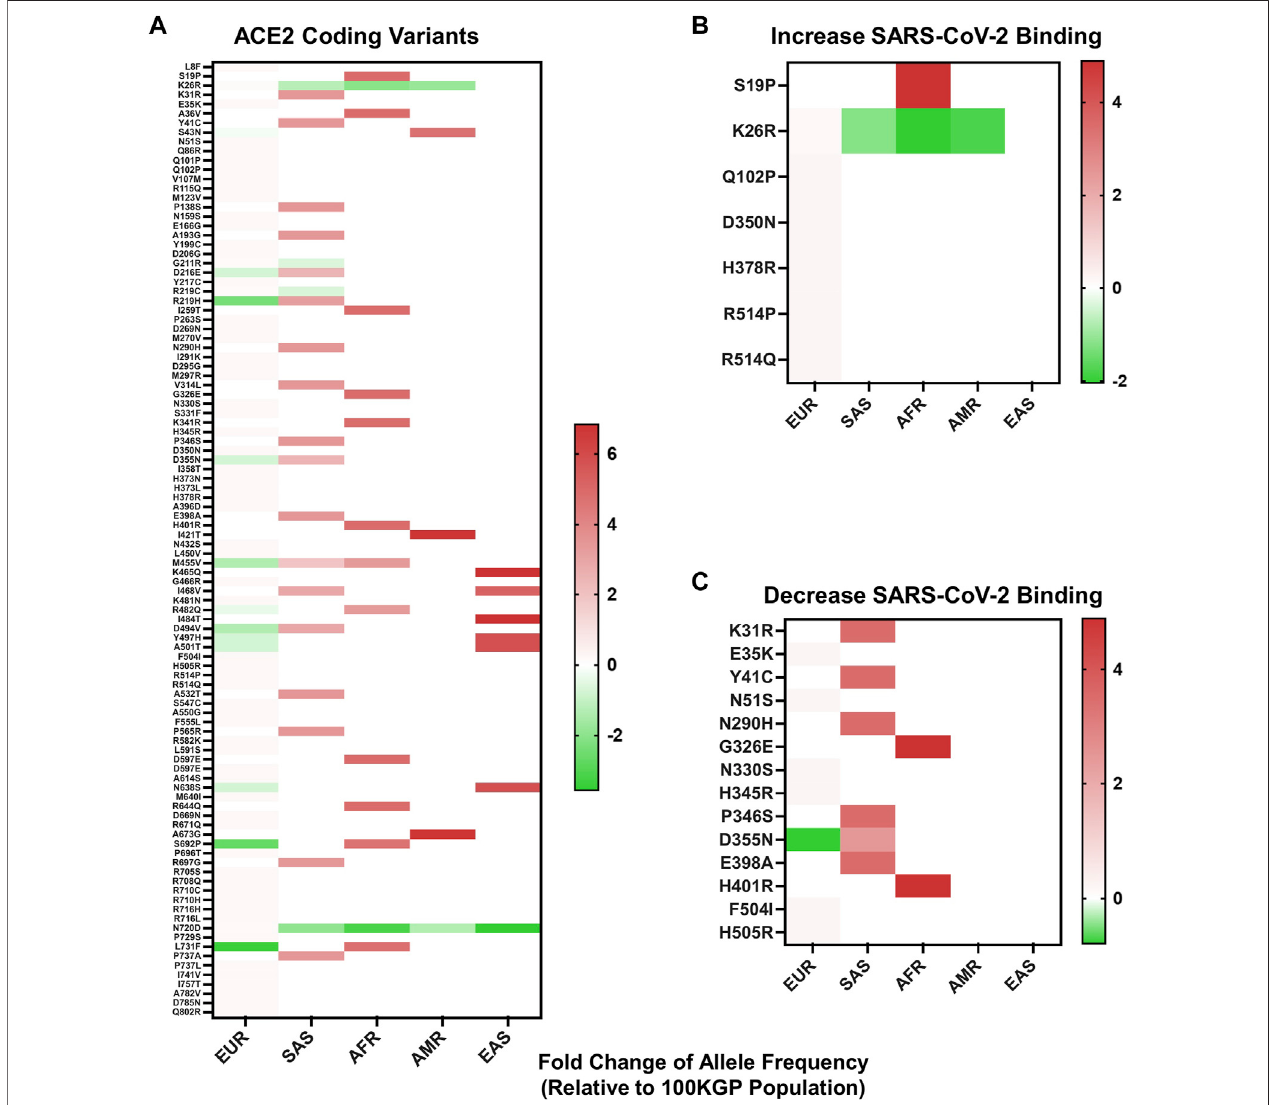
FIGURE 2| Allelic frequency ofnonsynonymous ACE2 variants in different ethnicities. (A) Allelic frequency of ACE2 coding variants present inindividual ethnicities, graphedasalogbase2-foldchangerelativetotheallelic frequencyin100KGPunrelatedcontrols(n=37,207). (B) Allelicfrequencyof ACE2 codingvariants inindividual ethnicities that increase SARS-CoV-2 S protein binding af fi nity for ACE2. (C) Allelic frequency of ACE2 coding variants in separate ethnicities that decrease SARS-CoV- 2Sproteinbindingaf fi nityforACE2.Allheatmapsaregraphedwithvaluesbelowandabovezerosetrelativetothedataset.Shadesofredindicateincreasedallelic frequency and green decreased allelic frequency, with lighter shades appearing as values move closer to no appreciated change relative to the 100KGP allelic frequencies, as indicated by white. Coding variants displayed by protein location and amino acid change.